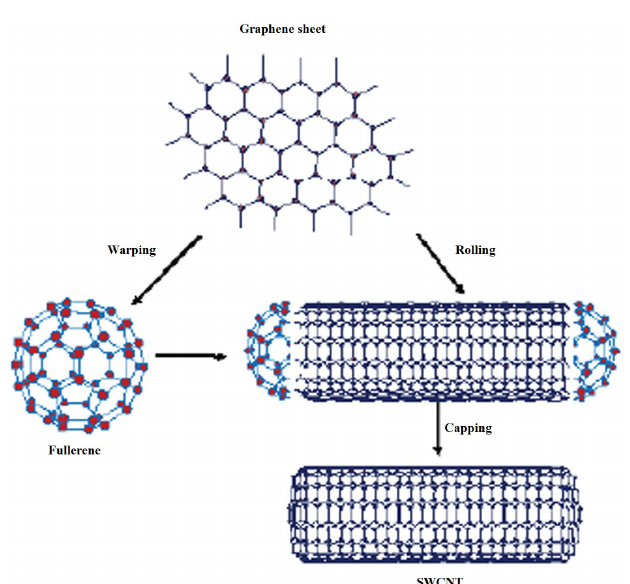
FIGURE 1 - The structure of SWCNTs with the two ends closed (Taylor et al.,